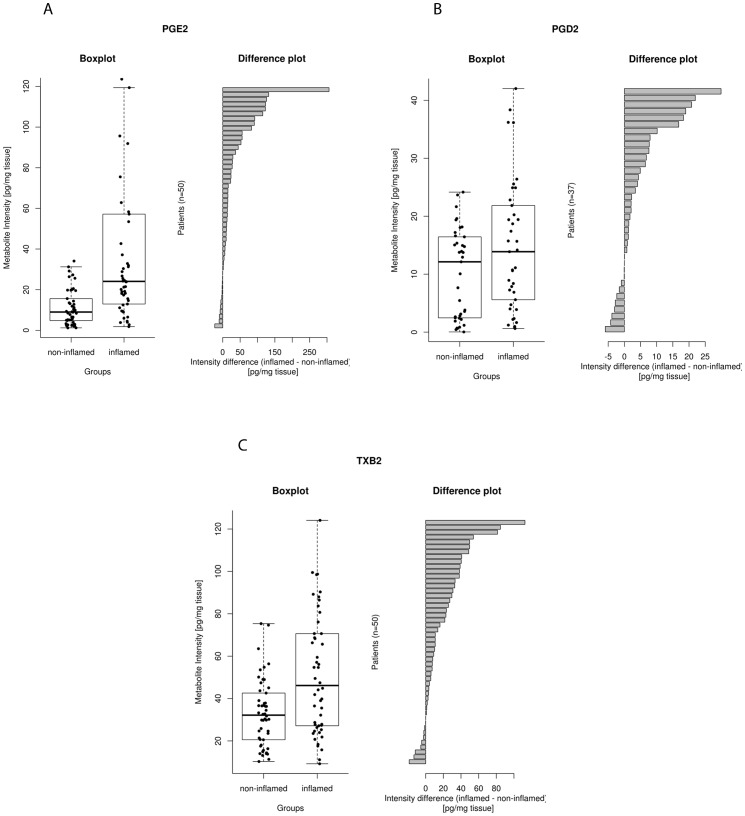
Median and interquartile range of COX-related lipid mediators (pg/mg tissue) in grouped non-inflamed and adjacent inflamed mucosa with difference plots of paired samples.3A: PGE2; 3B: PGD2; 3C: TXB2.